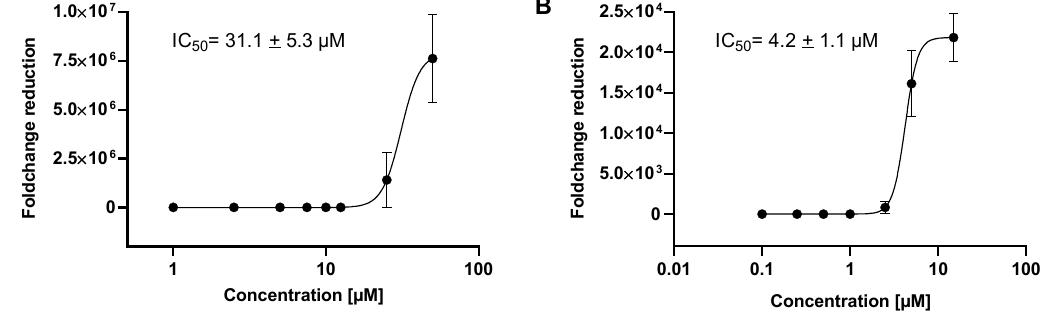
Figure 4. Inhibition of SARS-CoV-2 viral replication by HHS and remdesivir for 24 h, ( A ) HHS, ( B ) remdesivir. IC 50 values are the concentrations where the viral infection was inhibited by 50%. Values were calculated by GraphPad Prism 9 and represent the means ± SD of three determinations.